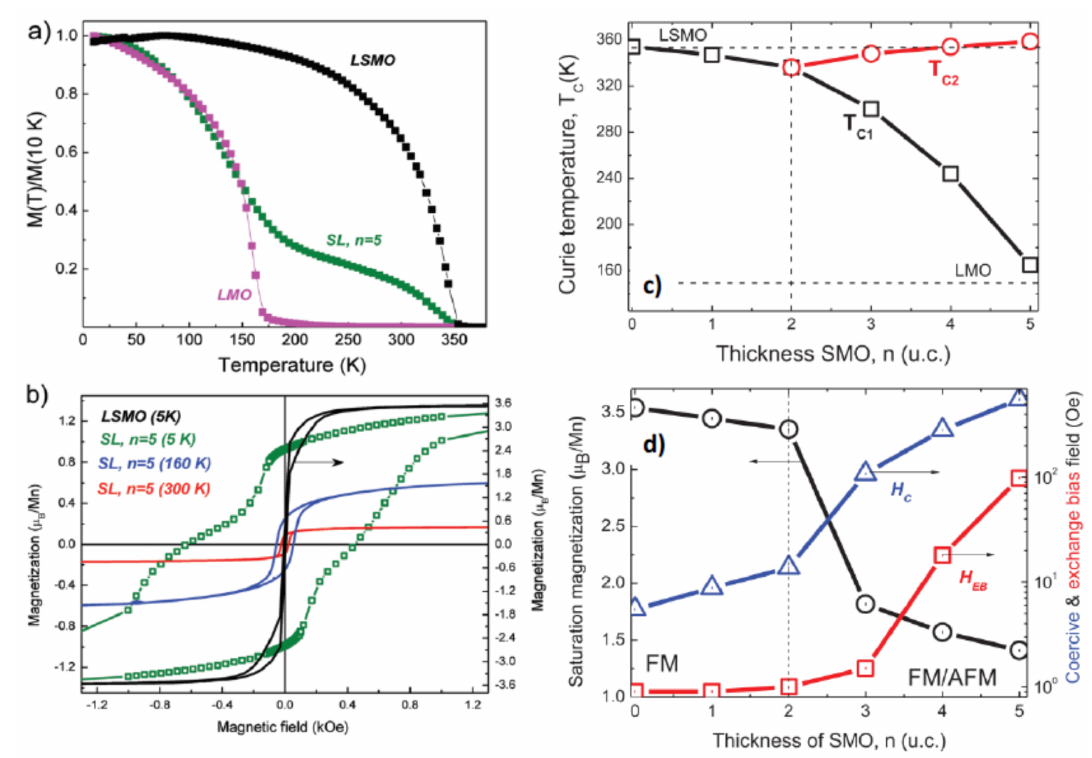
Figure 12. ( a ) M(T) dependences with phase transitions at T C (LSMO) = 355 K and T C (LMO) ≈ 160 K and a two-phase behavior for a superlattice (SL) with n = 5; ( b ) M ( H ) curves measured at 5 K: LSMO (black curve, right scale) shows low coercivity and optimally large M sat = 3.6 µ B / Mn. SL with n = 5 reveals suppressed M sat = 1.3 µ B / Mn (olive), huge coercive field ( H c = 550 Oe) and a pronounced exchange bias field ( H EB = 100 Oe). The high- T C FM phase in the SL is evidenced by the M ( H ) curve @ 300 K (red) and @ T = 160 K (blue); ( c ) Curie ( T C ) temperature behavior shows the emergence of a high- T C2 FM and reduction of T C1 for n > 2; ( d ) Increase in H c and appearance of H EB accompanied by suppression of M sat illustrate a progressive AFM enhancement in SLs with n > 2. A phase boundary at n ≈ 2 separates a homogeneous FM and an FM / AFM phase coexistence in SLs. “Reprinted figure from [34] under permission licensed by John Wiley and Sons (Nr.